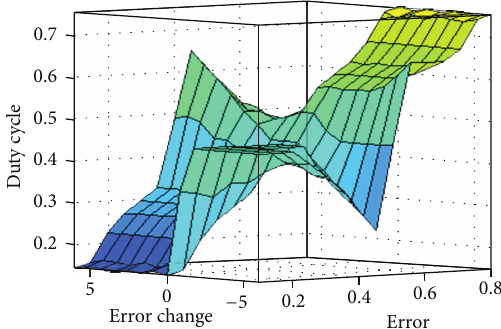
Figure 15: Surface view of fuzzy input versus output functions.